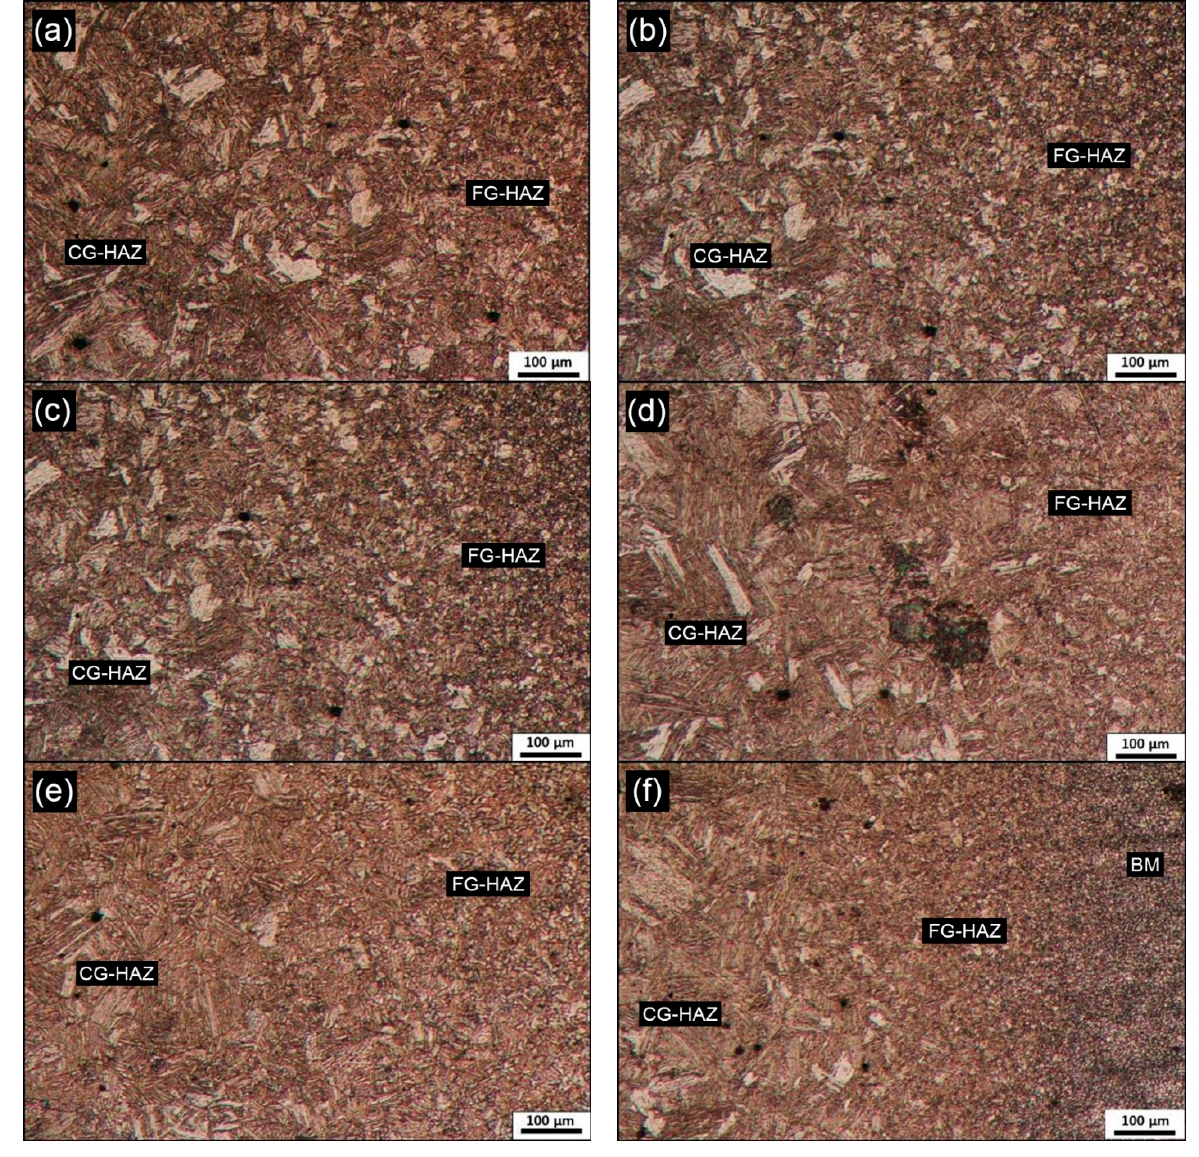
Figure 5. Effect of heat input on microstructure of HAZ, ( a ) 1.764 kJ/mm, ( b ) 1.995 kJ/mm, ( c ) 2.035 kJ/mm, ( d ) 2.132 kJ/mm, ( e ) 2.229 kJ/mm, ( f ) 2.33 kJ/mm.